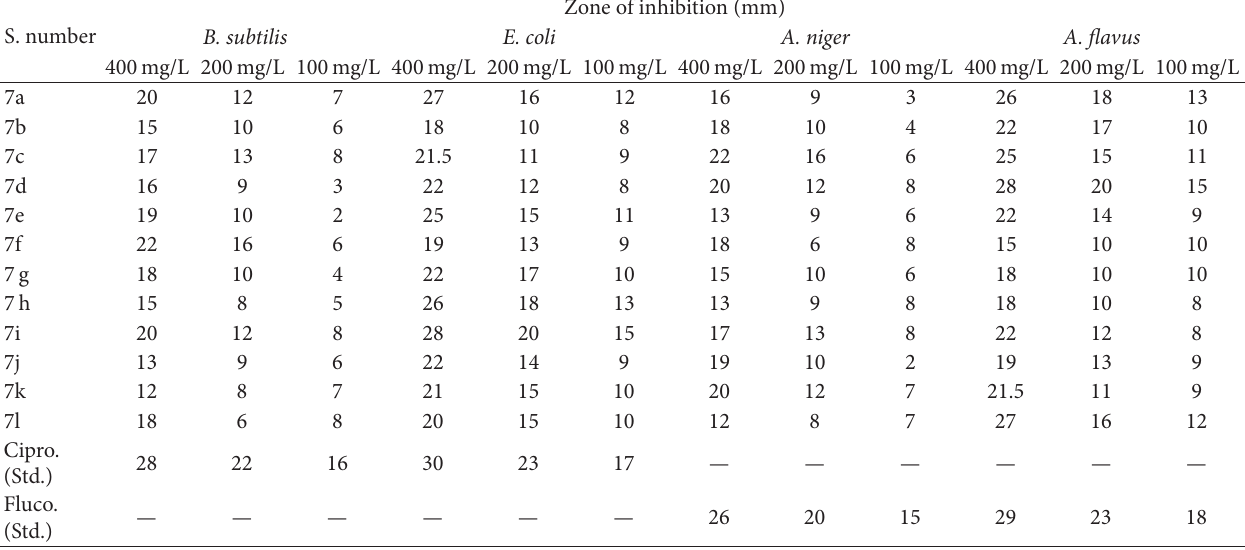
T 1: Antibacterial and antifungal activities of synthesized compounds using disc diffusion